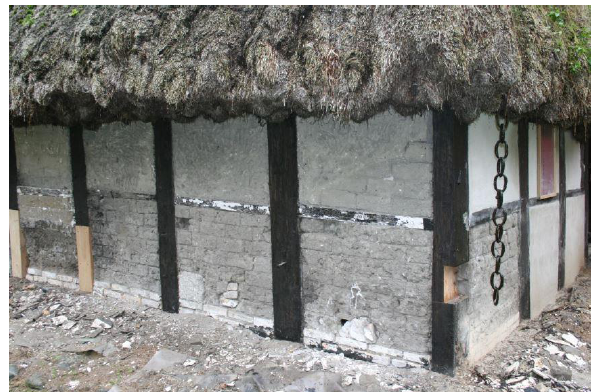
Figure 7. Original infills are walled up with adobes (Photographer Søren Kibsgaard).